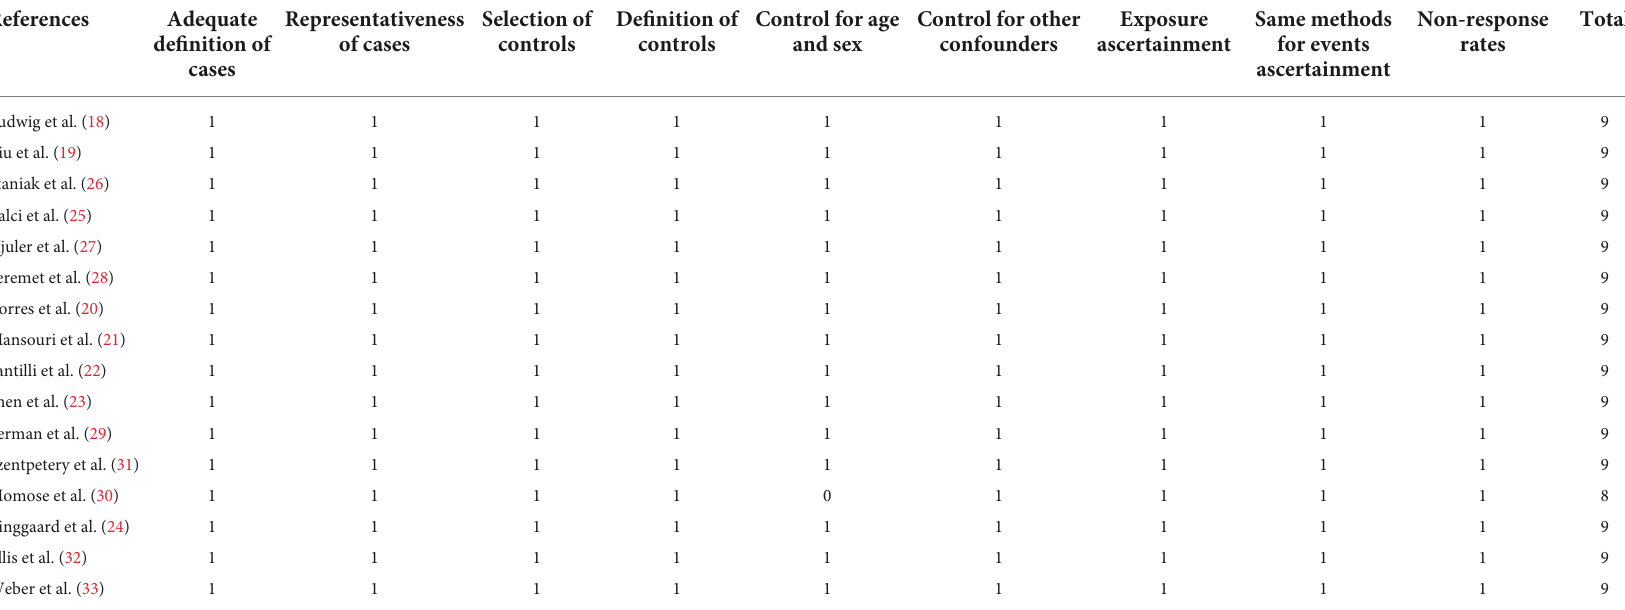
TABLE 2 Study quality evaluation using the Newcastle-Ottawa Scale